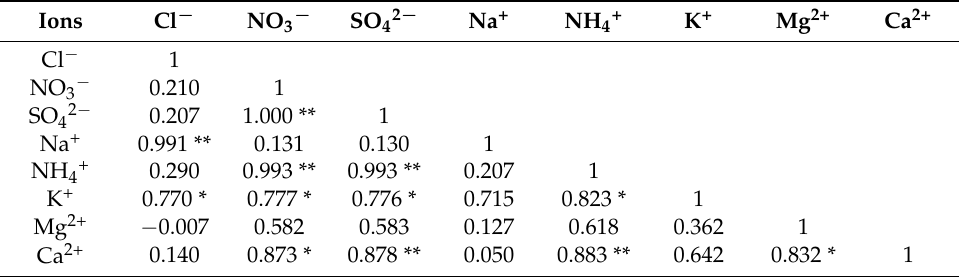
Table 2. The correlation matrix for ion concentrations in Mt. Yulong snowpits.